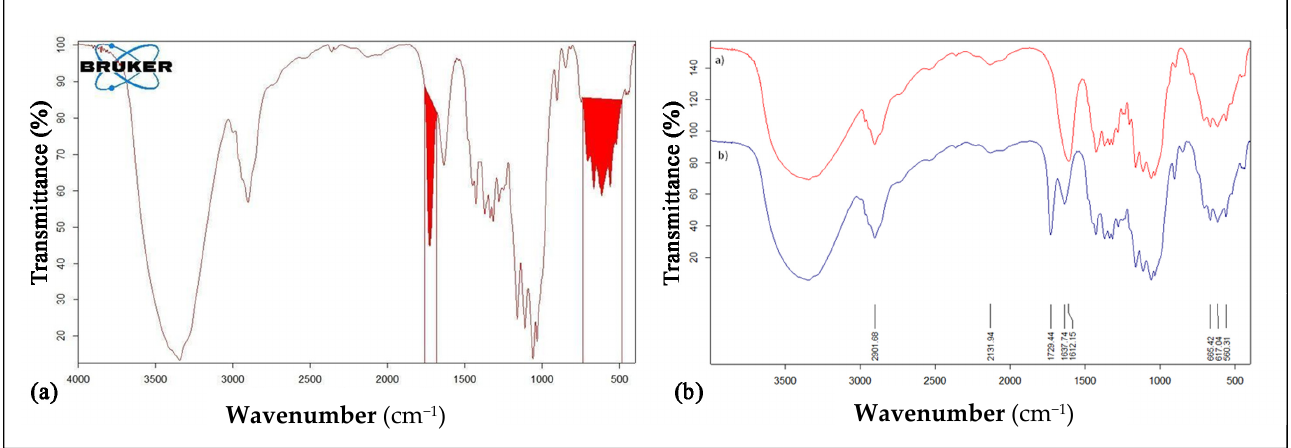
Figure 4. ( a ) FT-IT analysis of ONC-GMA in salt form highlighting peaks integrated for MS calcu- lations. ( b ) Comparison between FT-IR spectra of ONC-GMA in its salt form (blue) and ONC salt form